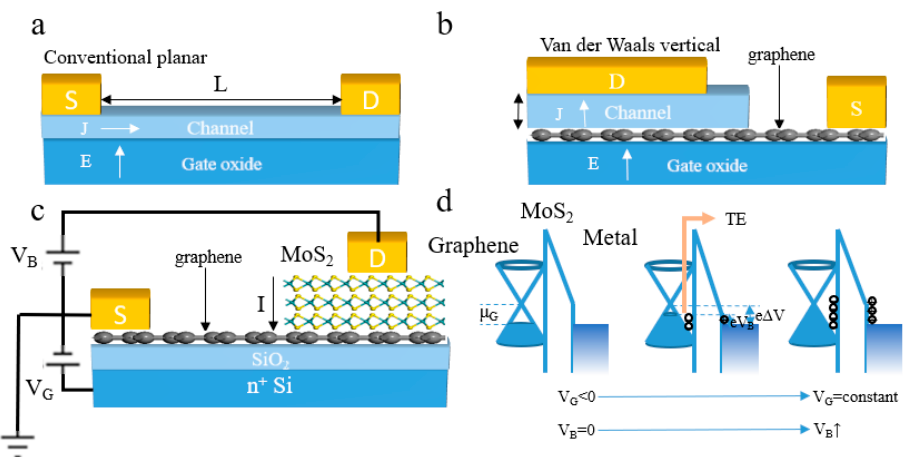
Figure 8. Van der Waals vertical stack structure and devices: ( a ) conventional planar transistor, channel current exists in planar area; ( b ) van der Waals vertical stack and channel current follow in vertical direction; ( a , b ) are adapted with the permission of Nature Publishing Group in Ref [5] ( c ) schematic of metal/MoS 2 /graphene vertical stack and measurement circuit; Adapted with the permission of AIP Publishing LLC in Ref [94] ( d ) band alignment of metal/MoS 2 /graphene vertical stack with a constant V G and changing with the increase of V B . Adapted with the permission of American Institute of Physics Publishing LLC in Ref [95].